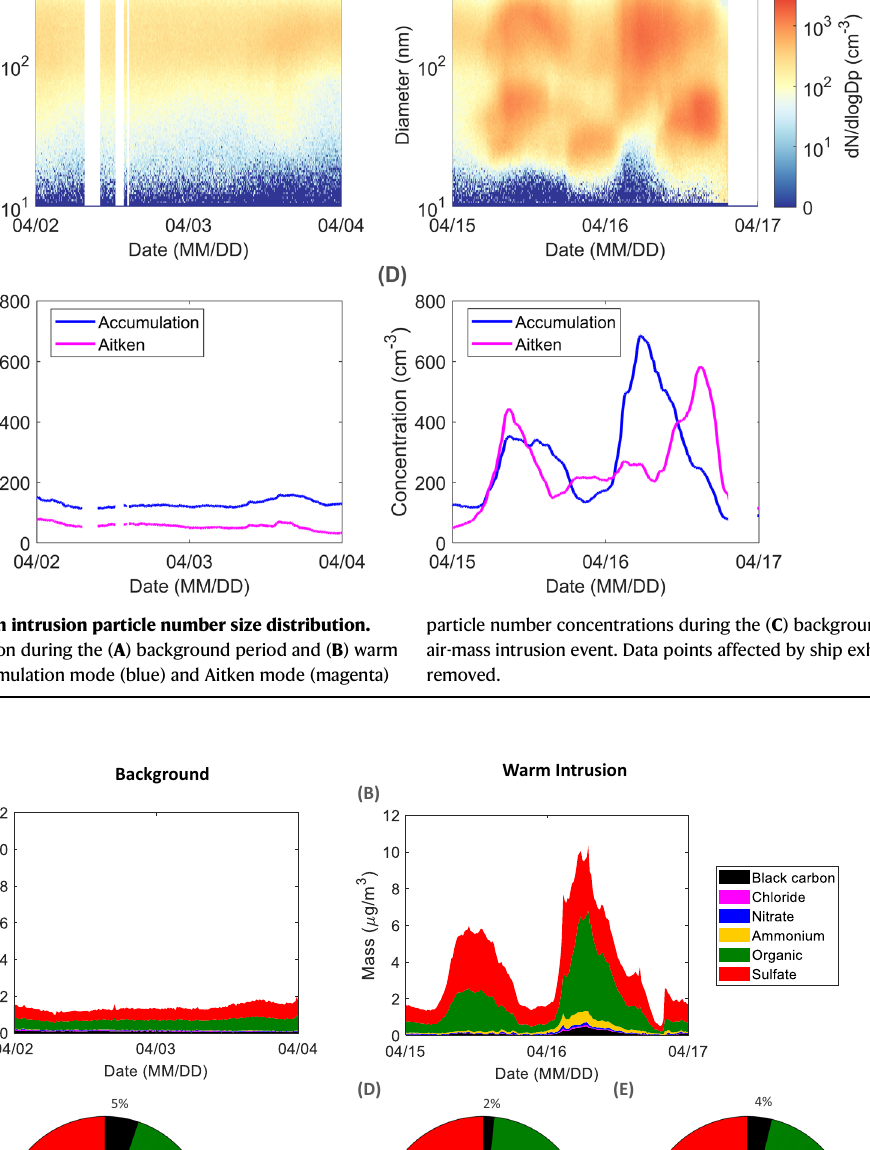
1 µ m) during ( C ) the background period, ( D ) the fi rst peak in PM 1 during the warm air-mass intrusion event (excluding precipitation periods) and ( E ) the second peak in PM 1 during the warm intrusion (excluding precipitation